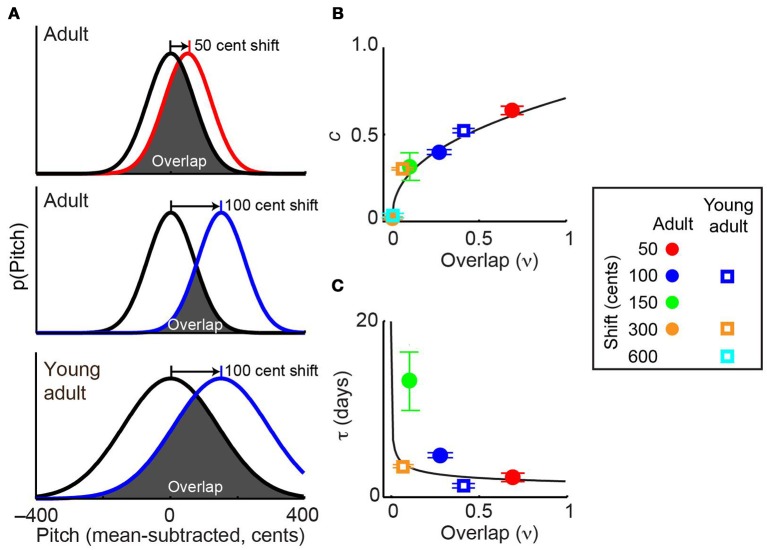
Overlap with prior distribution predicts the dynamics of sensorimotor adaptation. (A) Schematics show the overlap between baseline pitch distributions (black) and those experienced at the beginning of pitch shifts (colors). Adults (top two panels) have relatively low pitch variability. Because young-adults have higher variability, a given shift size (e.g., 100 cents) in a young-adult (bottom) will result in greater overlap than the same shift size in an older adult (middle). In this schematic, differences in adult and young-adult variability (Figure 1E) are exaggerated for visual clarity; the actual distributions for each individual subject are shown in Supplemental Figure 1. (B,C) The prior overlap model (see Methods) predicts adaptation dynamics across experimental conditions. When fit to the entire dataset, this model uses the overlap shown in (A) to predict the fit values of c, which quantifies the magnitude of adaptation and τ, the time constant of adaptation. Model predictions of c and τ are shown as black traces in (B,C), respectively. Values of c and τ in each experimental condition were obtained by fitting the standard exponential model (Equation 1) to each dataset. The standard exponential model did not converge on a value of τ for the 300-cent data in adult subjects or the 600-cent data in young-adults (see text). Error bars in (B) and (C) indicate 95% confidence intervals and in some cases are partially obscured by symbols. Inset at right shows color and symbol conventions. Note that symbols representing ±300-cent shifts in adults (orange circle) is partially obscured by the symbol representing ±600-cent shifts in young-adults (cyan square) in (B).